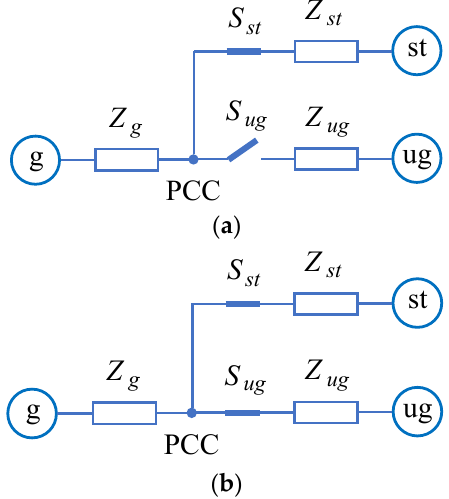
Figure 13. Diagram of the power system with STATCOM during voltage sags for ( a ) islanded and ( b ) grid ‐ connected microgrid.